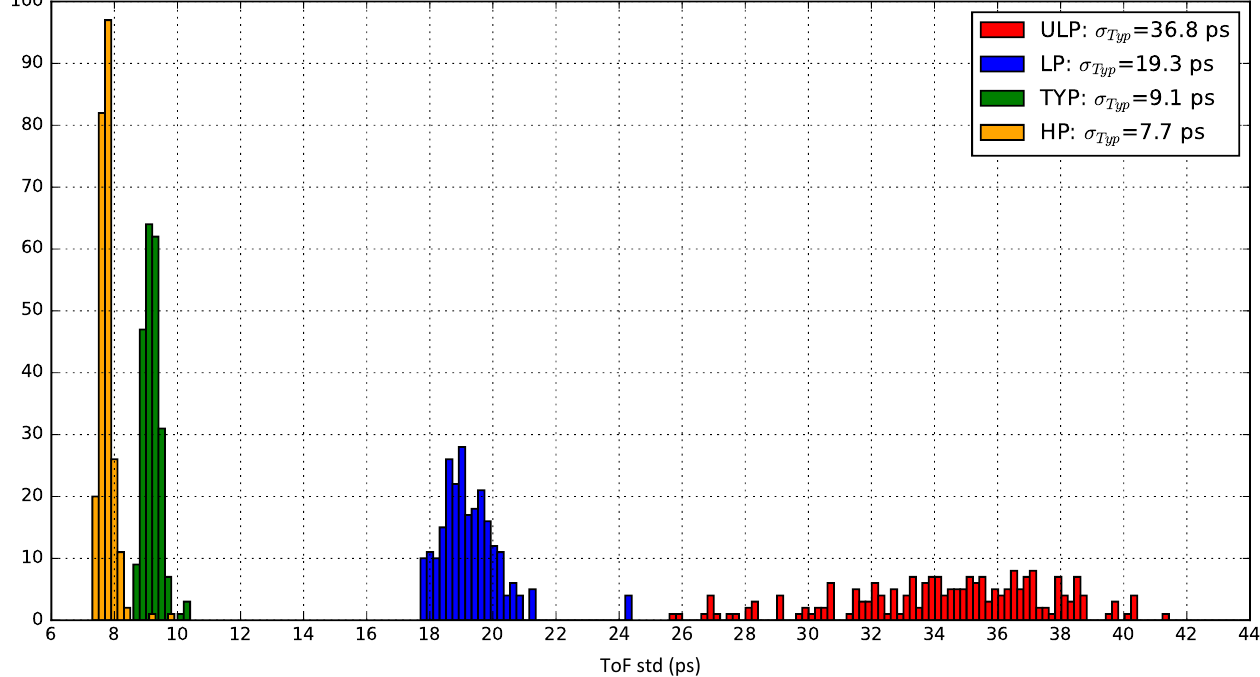
Figure 14. ToF jitter standard deviation for each MATRIX16 channel sample (after bin calibration).